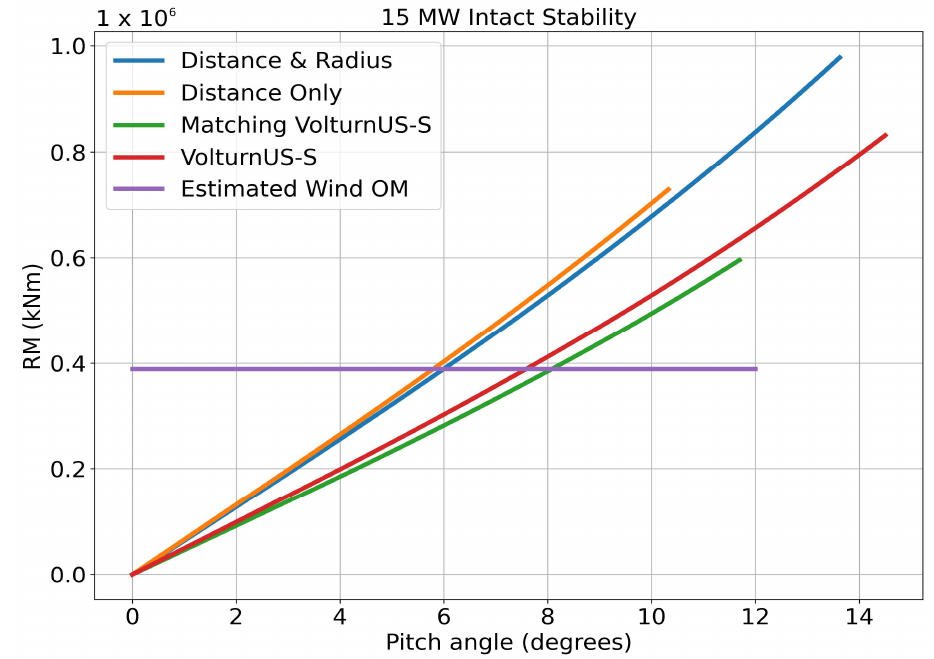
Figure 6. Intact Stability Curves for 15 MW Floating Offshore Wind Turbines.